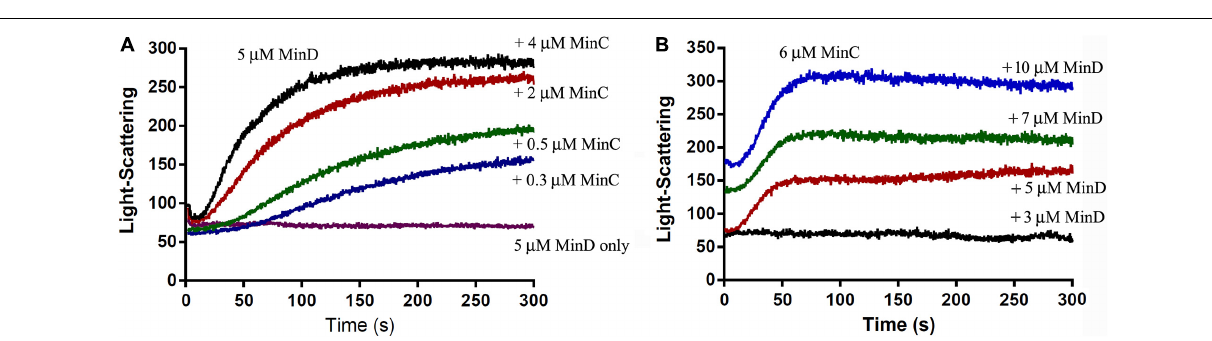
FIGURE 3 | The comparison of the assembly kinetics of BsMinC and BsMinD at different concentrations suggested that BsMinD concentration dominated the coassembly of BsMinC-D. (A) Assembly kinetics of 5 µ M BsMinD and different concentrations of BsMinC from 0.3 to 4 µ M. (B) Assembly kinetics of 6 µ M BsMinC and different concentrations of BsMinD from 3 to 10 µ M. ATP concentration is 2